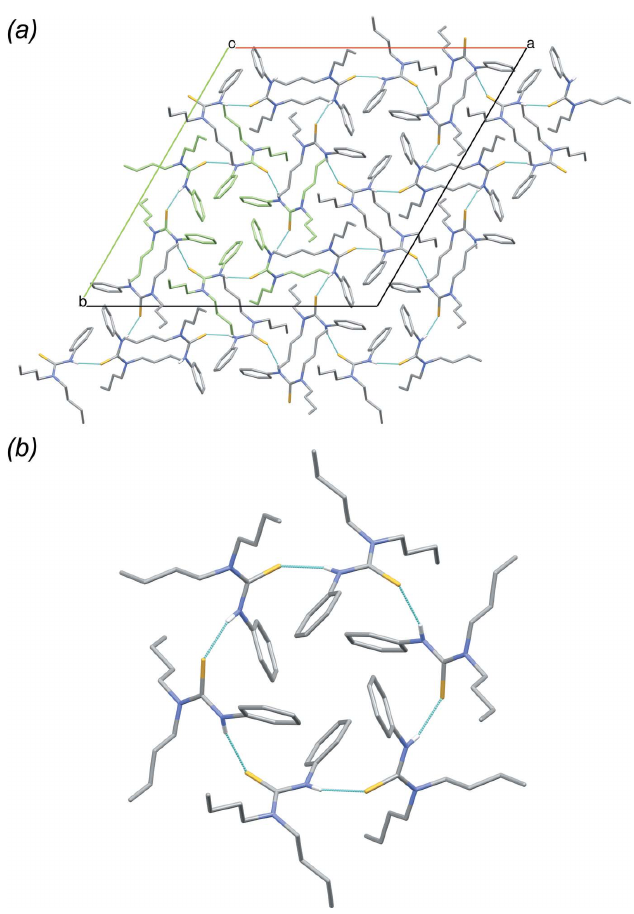
Figure 5 Packing in the structure of 3 , ( a ) viewed down the c axis, showing the hexamer ring assembly of molecules, around the threefold rotoinversion axes, with one hexamer highlighted (green). ( b ) Detail of one hydrogen- bonded hexamer ring assembly. Hydrogen atoms (except involved in hydrogen bonds) are omitted for clarity.